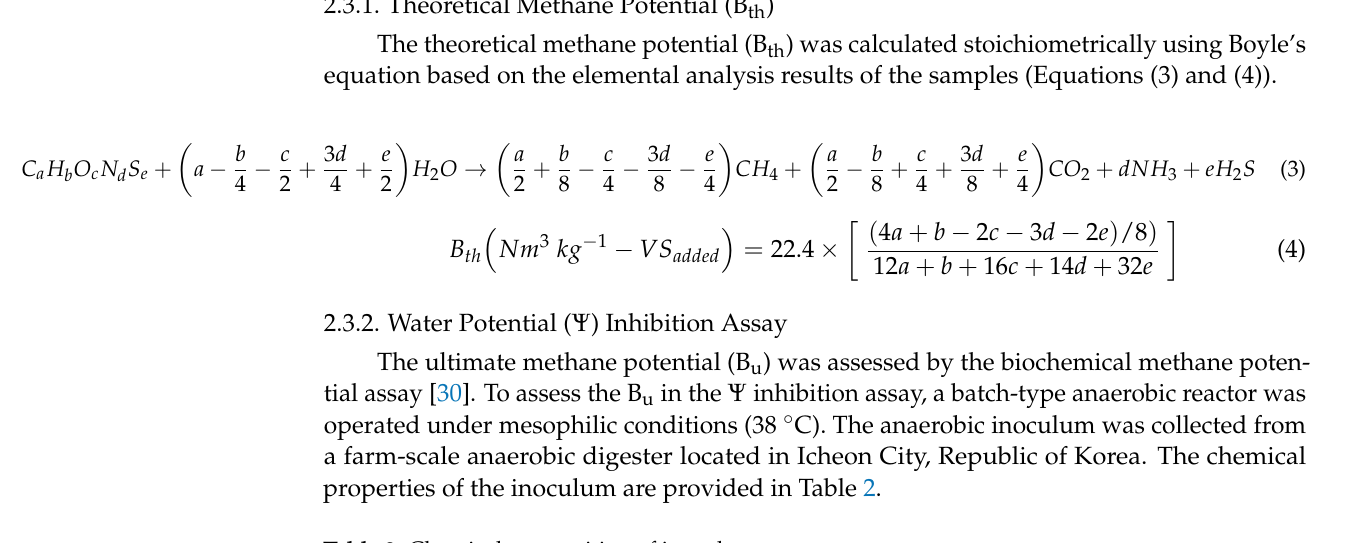
Table 2. Chemical composition of